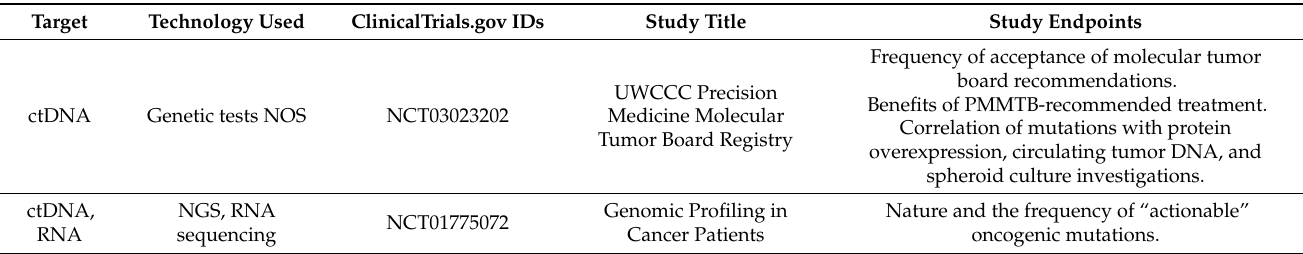
Table 2. Ongoing studies on LBx in hematologic malignancies, provided by the ClinicalTrials.gov search engine, current as of the date of this